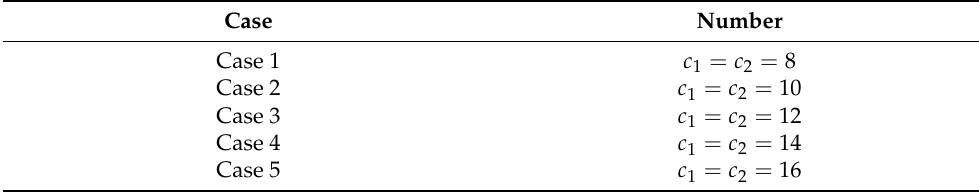
Table 2. The number of input parameters in the